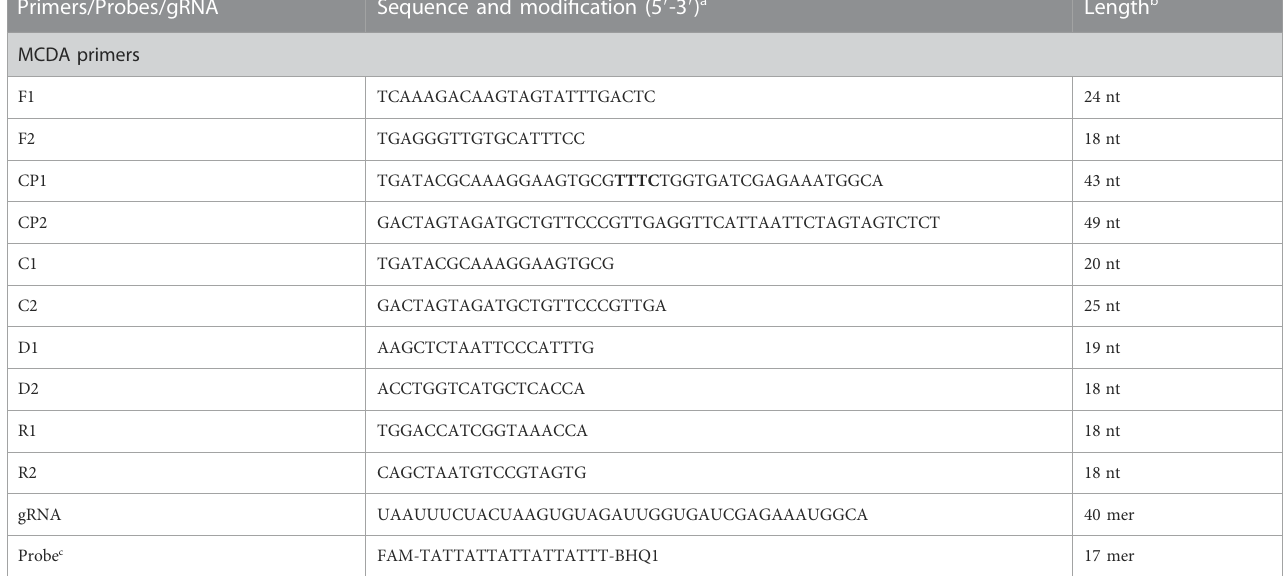
TABLE 2 The primers, probe, and gRNAs used in the current study. Primers/Probes/gRNA Sequence and modi fi cation (5 ′ -3 ′ ) a